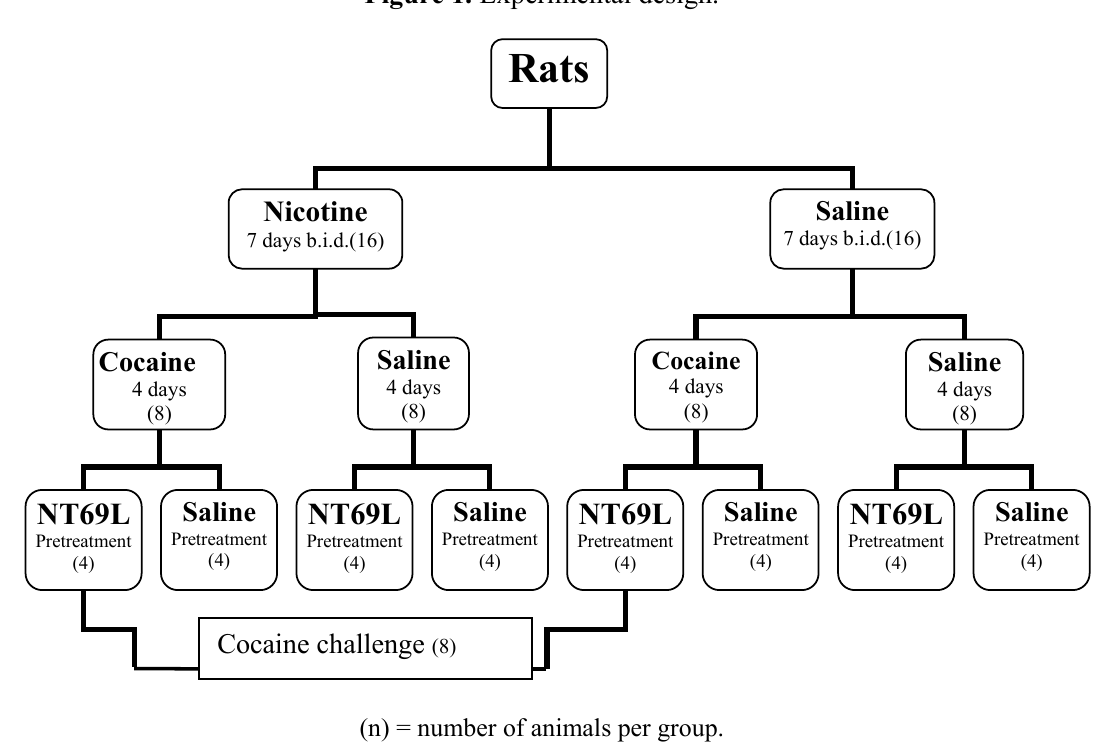
Figure 1. Experimental design.